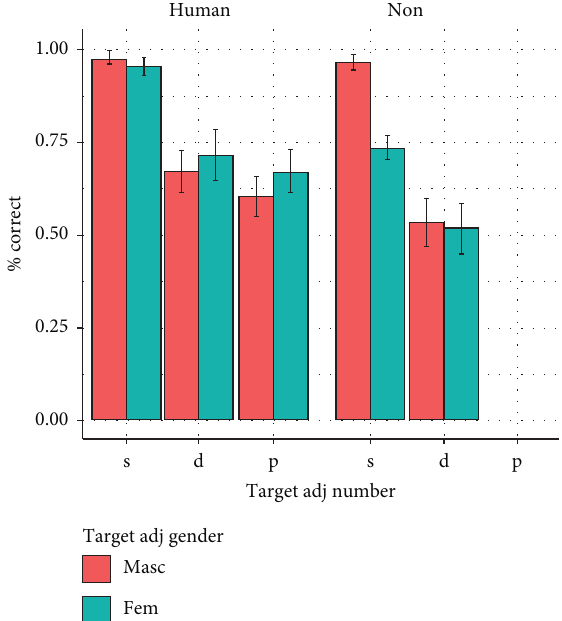
Figure 4: Mean % correct for singular, dual and plural adjective inflection for LP.